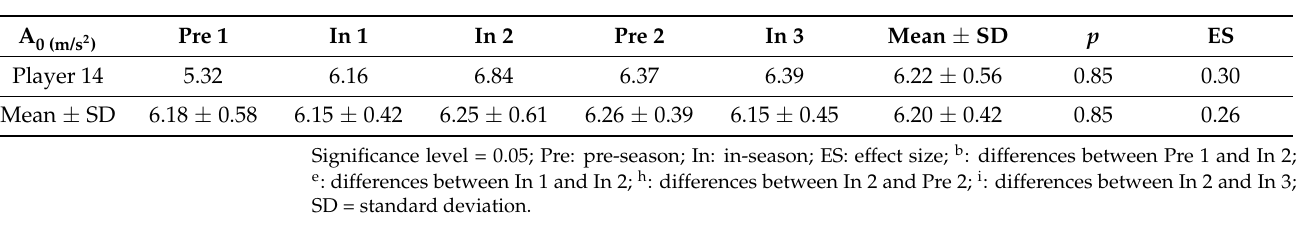
Table 2. Theoretical maximal speed per player period and difference in means.